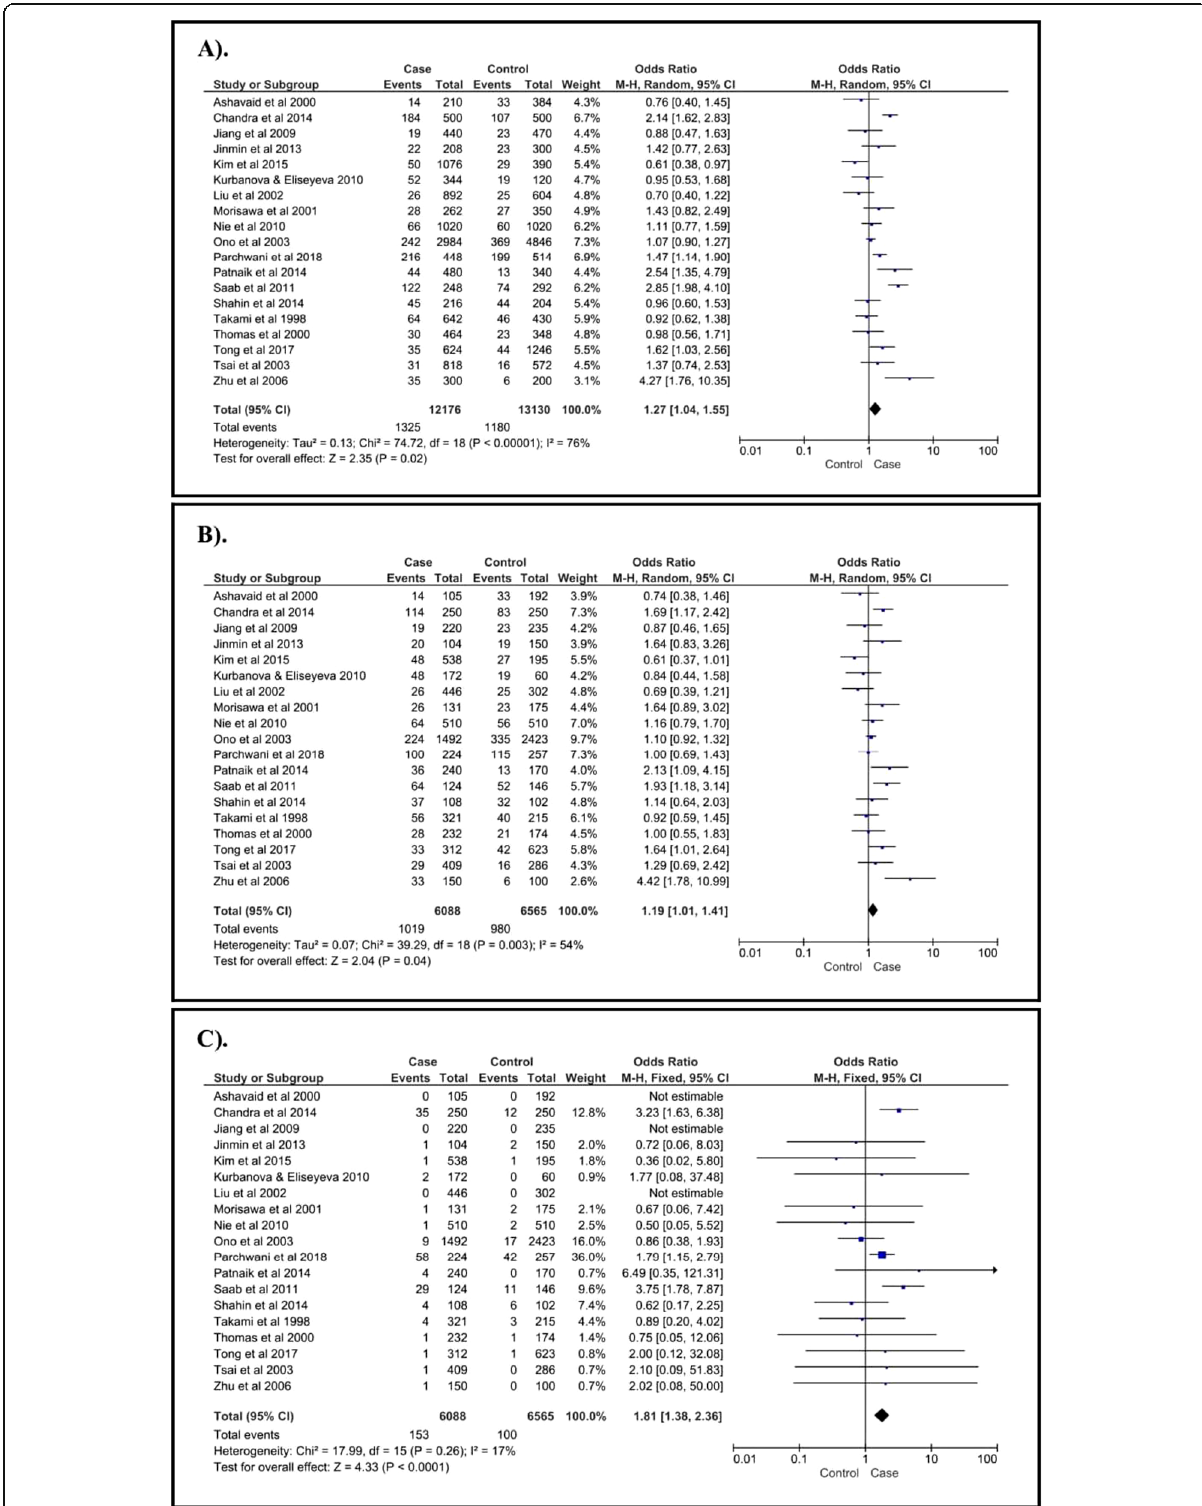
Fig. 4 The association between AT1R A1166C gene polymorphism and the risk of essential hypertension in the Asian sub-group. a . C vs. A, b ) AC vs. AA + CC, and c ) CC vs. AA +